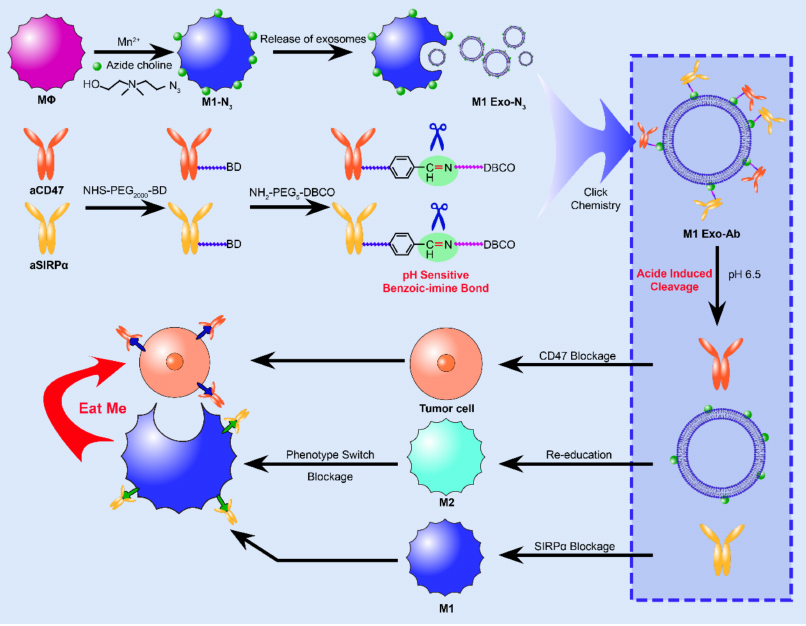
Figure 6. Mn 2+ was used as an inducer to polarize macrophages into anti-tumor M1 macrophages. At the same time, the membrane is modified with azide groups through the inherent biosynthesis and metabolic incorporation of phospholipids. Then the azide modified M1 Exo was coupled with dibenzocyctocene (DBCO) modified anti-CD47 antibody (aCD47) and pH-sensitive anti-signal regula- tory protein alpha (SIRP α ) antibody (aSIRP α ). After acid-induced division, antibodies are separated from exosomes, which repolarize M2-type macrophages into M1-type macrophages. ACD47 acts on CD47 overexpressed by tumor cells to resist the “don’t eat me” signal. Meanwhile, aSIRPa acts on SIRPA of macrophages to prevent phagocytic cells from losing their phagocytic ability. And then the phagocytes will eat the tumor